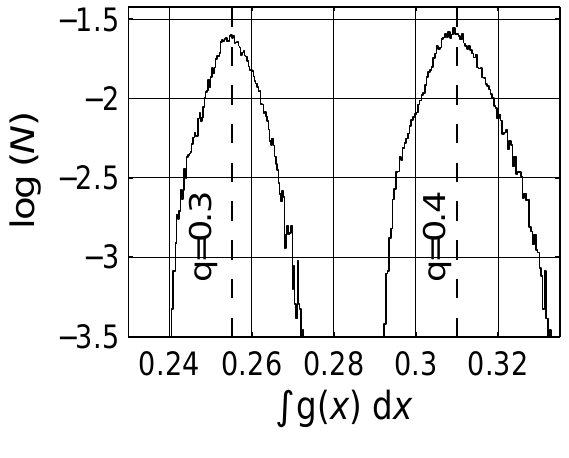
Figure 13 . The number density distribution of estimated q levels, q = { 0 . 3 , 0 . 4 } . The dashed vertical lines are the expectation values of q , which are 0 . 255 ± 0 . 065 and 0 . 310 ± 0 . 096 for concentration levels 0 . 3 and 0 . 4 , respectively. Logarithmic scale is base